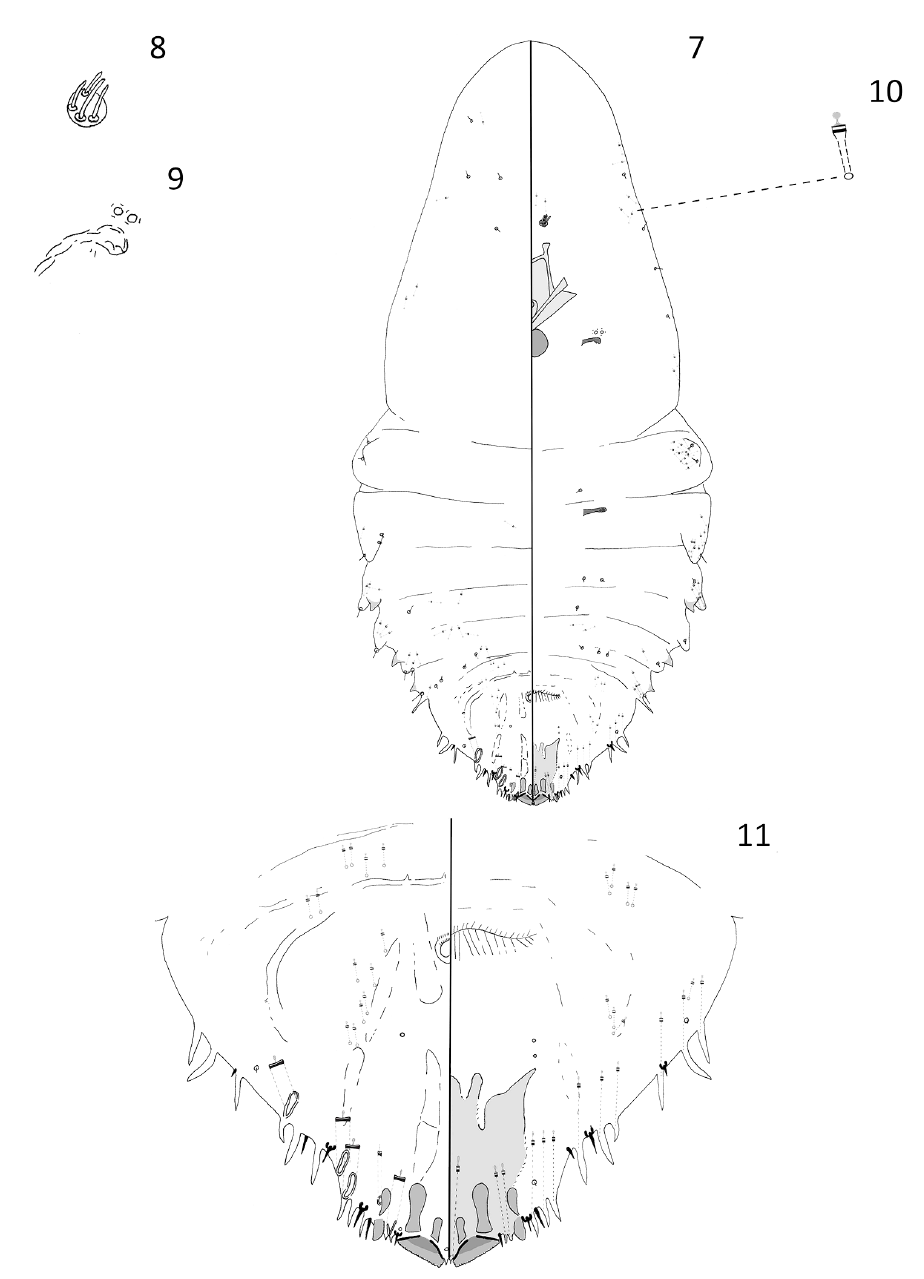
Figure 7–11. Andaspis conica Hamilton and Williams, sp. n., adult female; 7 whole body 8 antenna 9 anterior spiracle 10 microduct 11